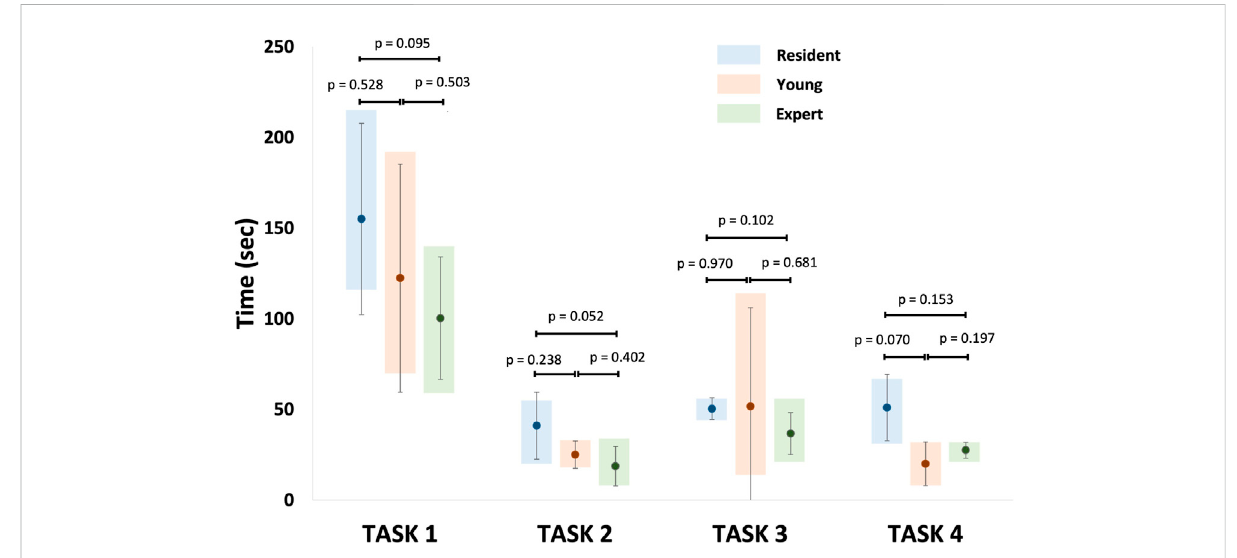
FIGURE 12 Representation of mean recorded operative times for each non-destructive tasks per group. Task 1: identi fi cation of normal anatomy landmarks;Task2:removalofaforeignbody(smallplasticsegment)fromthechoana;Task3:medializationofthemiddleturbinateandinsertionofa cottonoid into the middle meatus; Task 4: incision of the simulated nasal septum